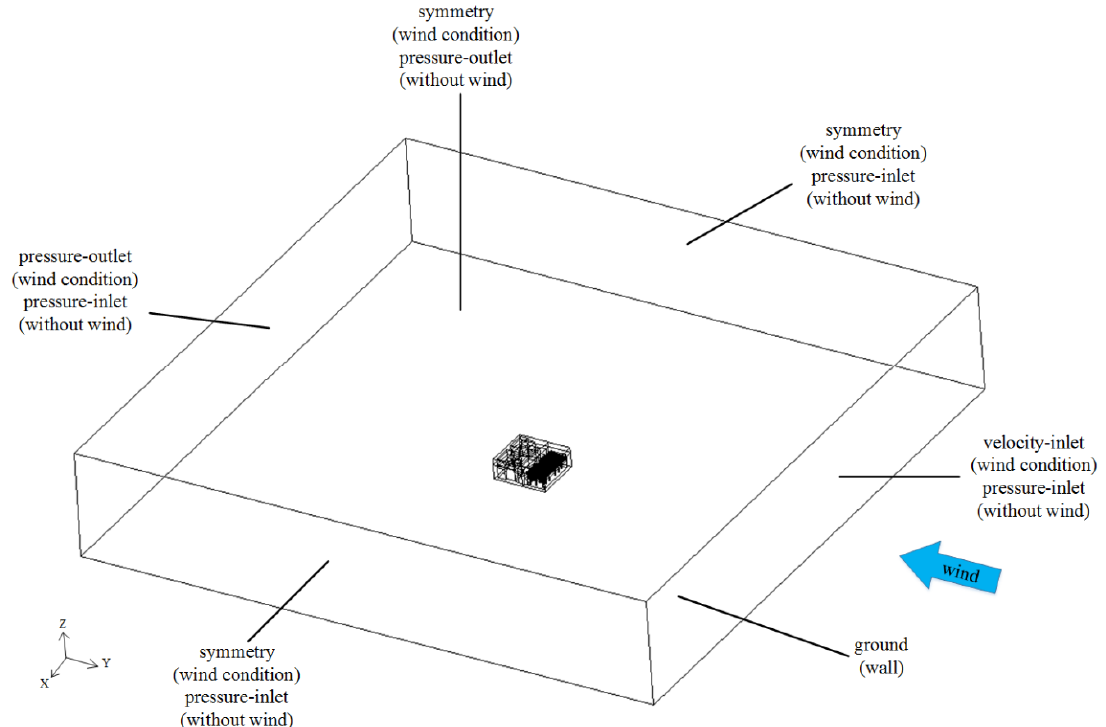
Figure 3. Computational domain and boundary conditions.